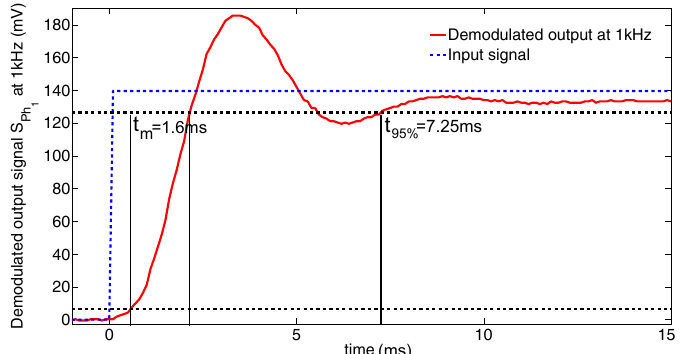
Figure 7. Experimental recording of the dynamic response of the demodulated output signal S at 1 kHz. The settling time at 95% t Ph 1 (the time required for the response to rise from 5% to 95% of its final value) is equal to 1.6 ms.